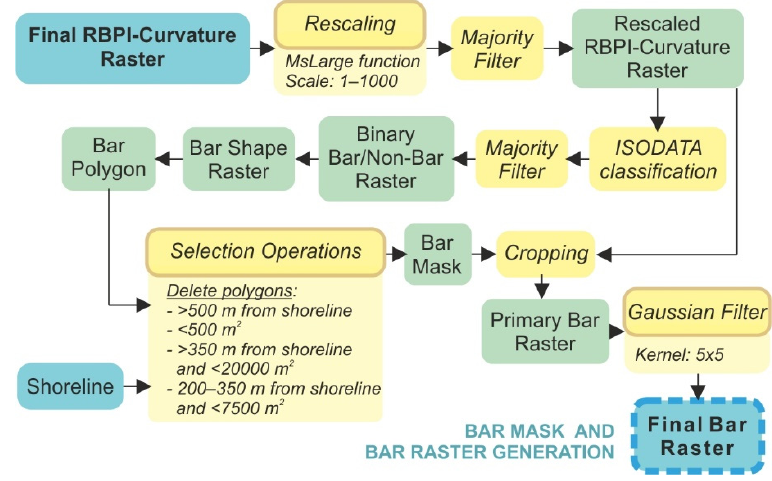
Figure 7. A flowchart of the sandbar extraction procedure.